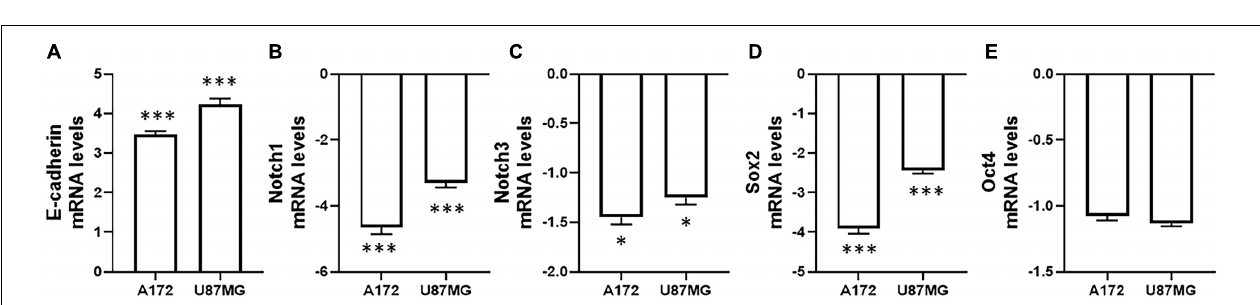
FIGURE 3 | Effect of SNHG6 downregulation on EMT and other related markers. Levels of (A) E-cadherin, (B) Notch1, (C) Notch3, (D) Sox2, and (E) Oct4 were evaluated in two glioma cell lines, as indicated, by qRT-PCR. GAPDH was evaluated as internal control. The relative values are plotted, which are fold-changes compared to the respective cells transfected with non-specific siRNAs. ∗ p < 0.05 and ∗∗∗ p < 0.01.